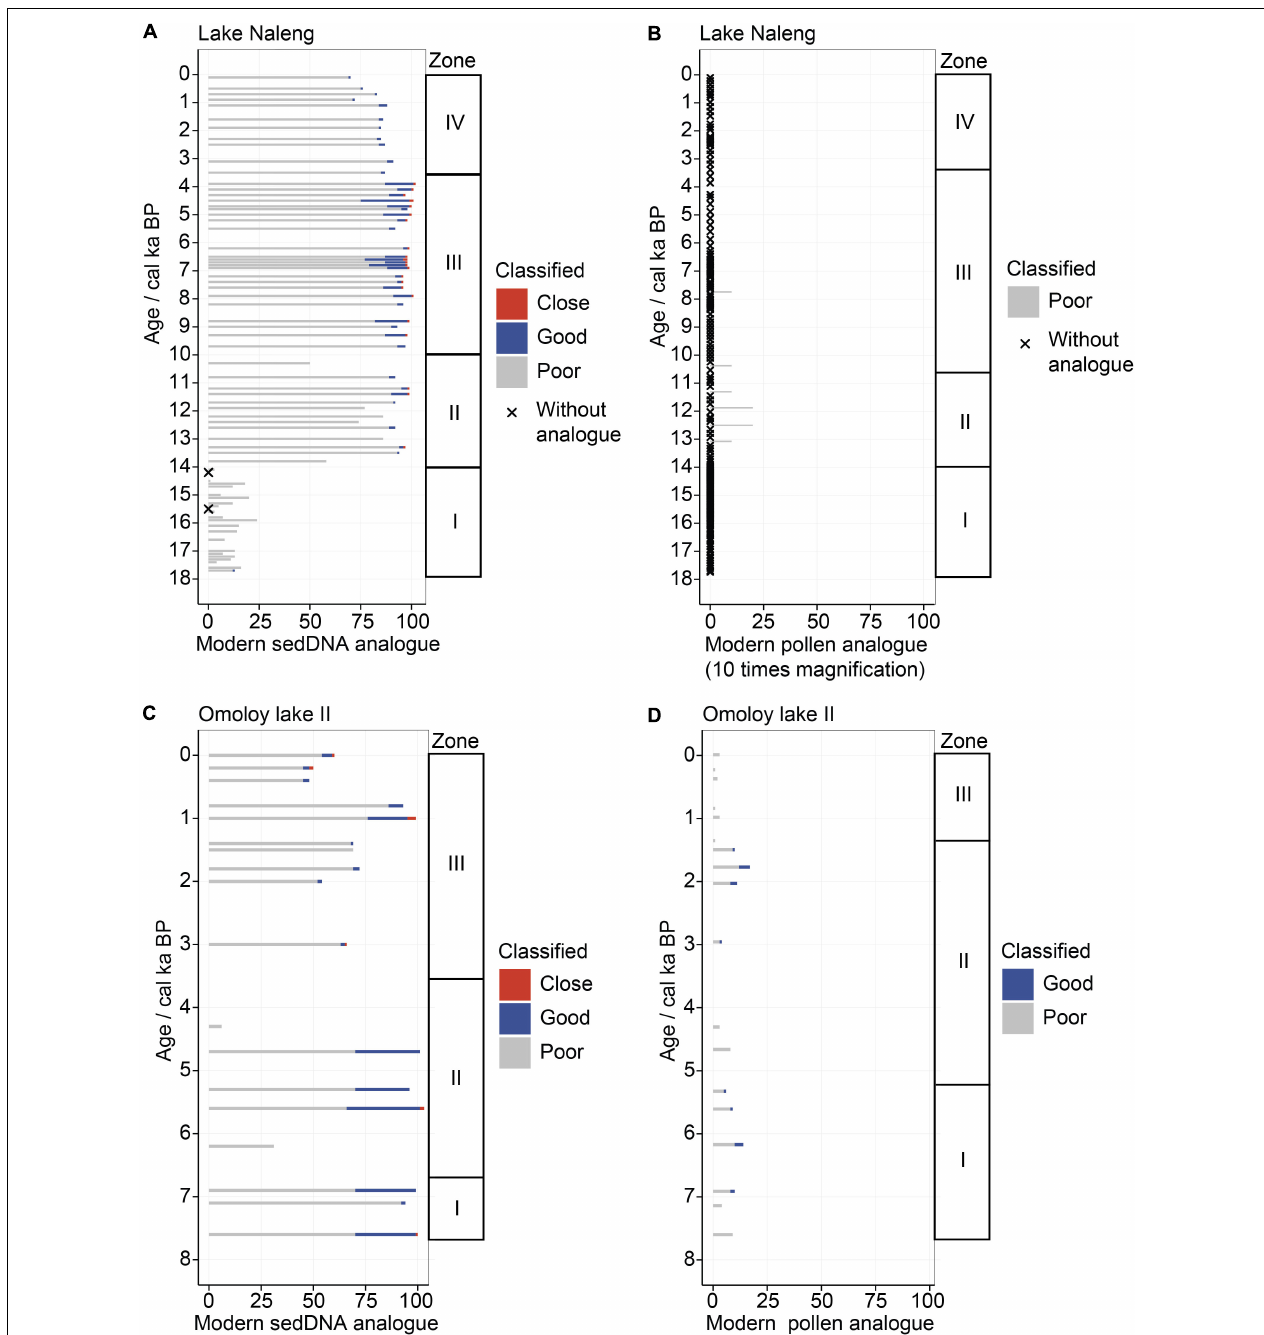
FIGURE 4 | Quality and number of modern analogues per sample for Lake Naleng (A,B) and Omoloy lake II (C,D) for sedDNA (left) and pollen (right). Number of modern analogues is estimated via receiver operating characteristic (ROC) curve analysis. More modern analogues are found for the modern sedDNA training-sets than the pollen ones. The modern analogues are classified as close ( < 1% percentile), good (1–5%), and poor ( > 5%). Fossil sediment samples without modern analogues are marked with an